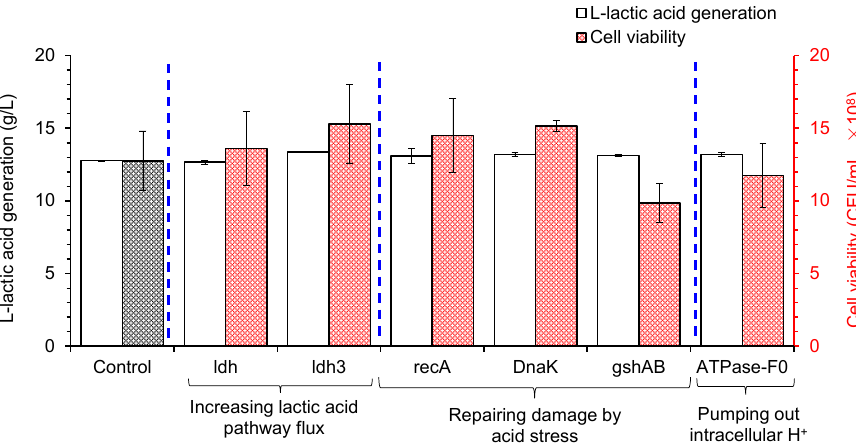
Figure 1. L-lactic acid fermentation of P. acidilactici recombinants in flasks at low pH. The low pH condition was formed with the generation of lactic acid during fermentation. The P. acidilactici re- combinant harboring empty plasmid pZY36e was used as the control. The ldh and ldh3 separately encoded L-lactate dehydrogenase from P. acidilactici ZY271 and L. acidophilus La-14. The recA and DnaK from P. acidilactici ZY271 encoded recombinase and chaperone, respectively. ATPase-F 0 en- coded F 0 subunit of F 0 F 1 -ATPase from P. acidilactici ZY271. The gshAB encoded glutamate cysteine synthase and glutathione synthetase from E. coli K12. The fermentation was performed in de Man, Rogosa and Sharpe (MRS) medium for 24 h, and the condition was control at 42 °C and 150 rpm. Cell viability and L-lactic acid generation were indicated at the end of the fermentation. According to Student’s t test, the p -value of each result was above 0.05. Two L-lactate dehydrogenases genes were cloned from the host strain P. acidilactici ZY271 ( ldh ) and Lactobacillus acidophilus La-14 ( ldh3 ) and expressed for the purpose of in- creasing the flux of lactic acid pathway, but no significant changes were observed. The genes responsible for DNA or protein damage repair by acid stress were ex- pressed in P. acidilactici ZY271. RecA encoding recombinase was able to repair DNA dam- age under low pH conditions [24]; Dnak encoding chaperone was reported to renature the